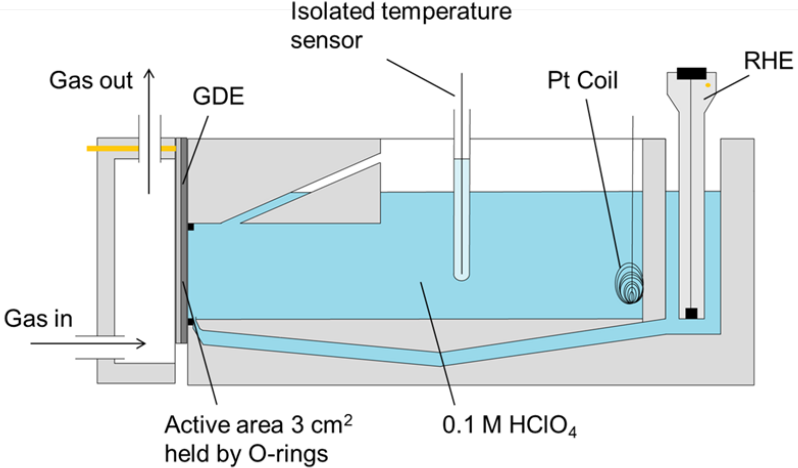
Figure 7. An illustration of the ex situ apparatus used in GDE testing. Reprinted with permission from ref [34]. Copyright 2020 American Chemical Society.